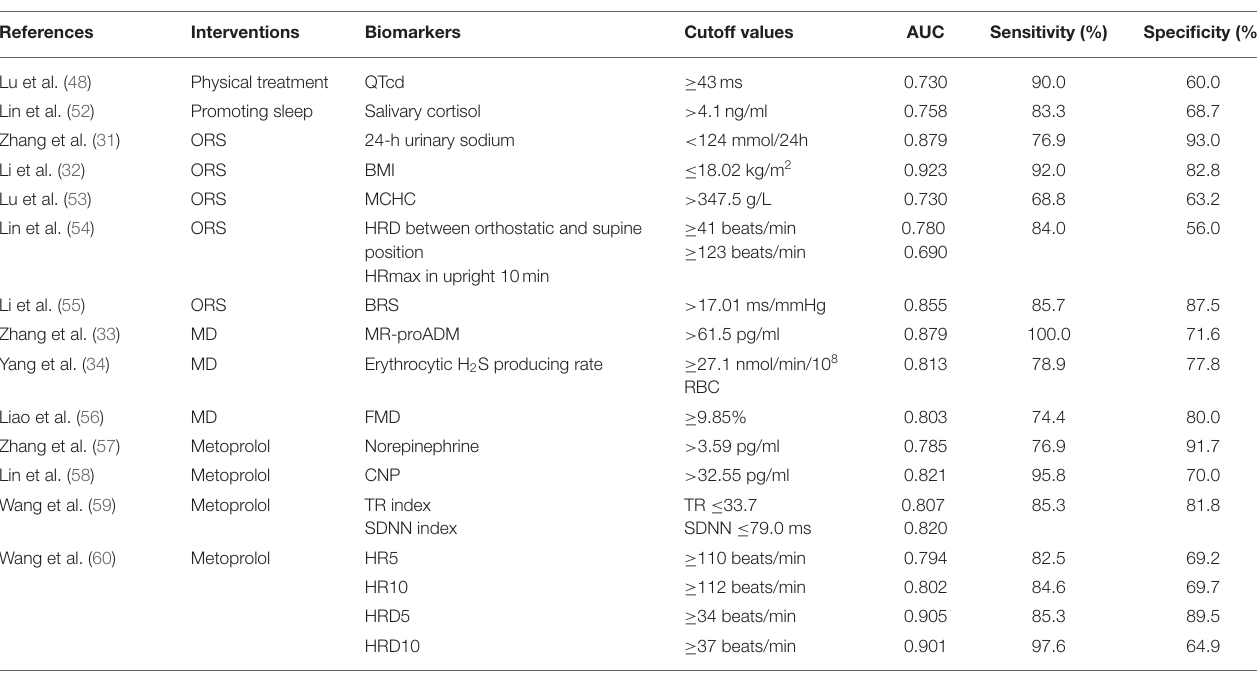
TABLE 2 | Predictors of therapeutic efficacy of pediatric